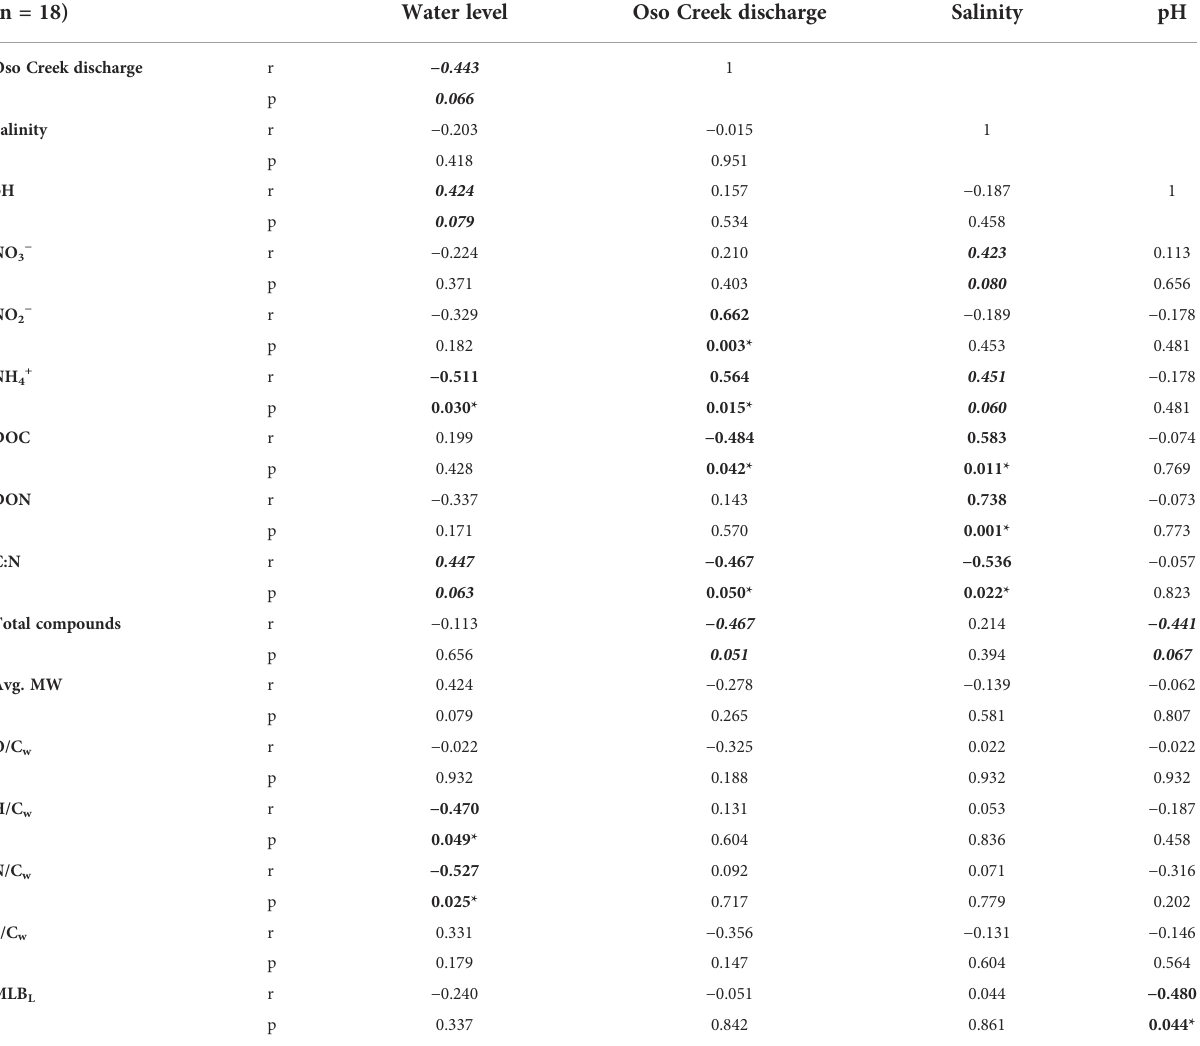
TABLE 1 Spearman ’ s rank correlations for inorganic and organic nutrients, dissolved organic matter chemical composition, and hydrologic metrics. (n = 18)